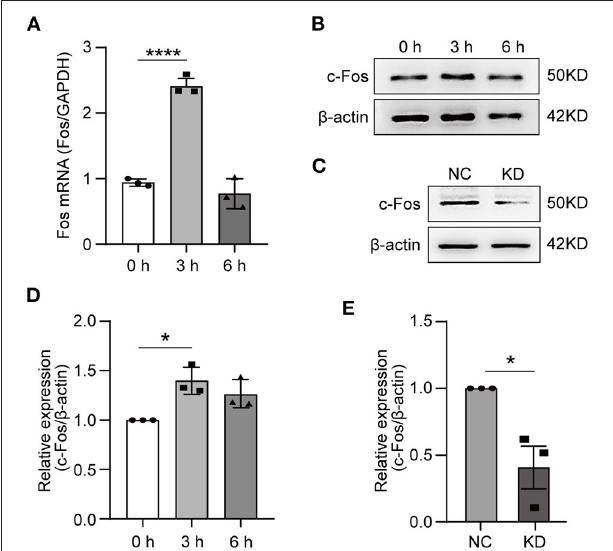
FIGURE 4 | Expression of Fos in HT22 cells. HT22 cells were treated by OGD for 0, 3, and 6h. The total RNA and protein were collected for analysis. (A) The Fos gene expression level in OGD cells was measured by quantitative real-time PCR. Glyceraldehyde-3-phosphate dehydrogenase (GAPDH) served as the control. (B) The c-Fos protein level in OGD cells was detected by Western blot (WB). (C) The knockdown efficiency was determined by WB. (D) Relative expression levels of c-Fos at each time point after OGD. (E) Relative expression levels of c-Fos in the NC group and KD. Each result is expressed as the mean of three independent experiments ± SEM. The statistical analysis of A were performed using one-way ANOVA, and the unpaired t -tests were used in (C) . * p < 0.05, **** p < 0.0001. NC, negative control cells; KD, knock-down